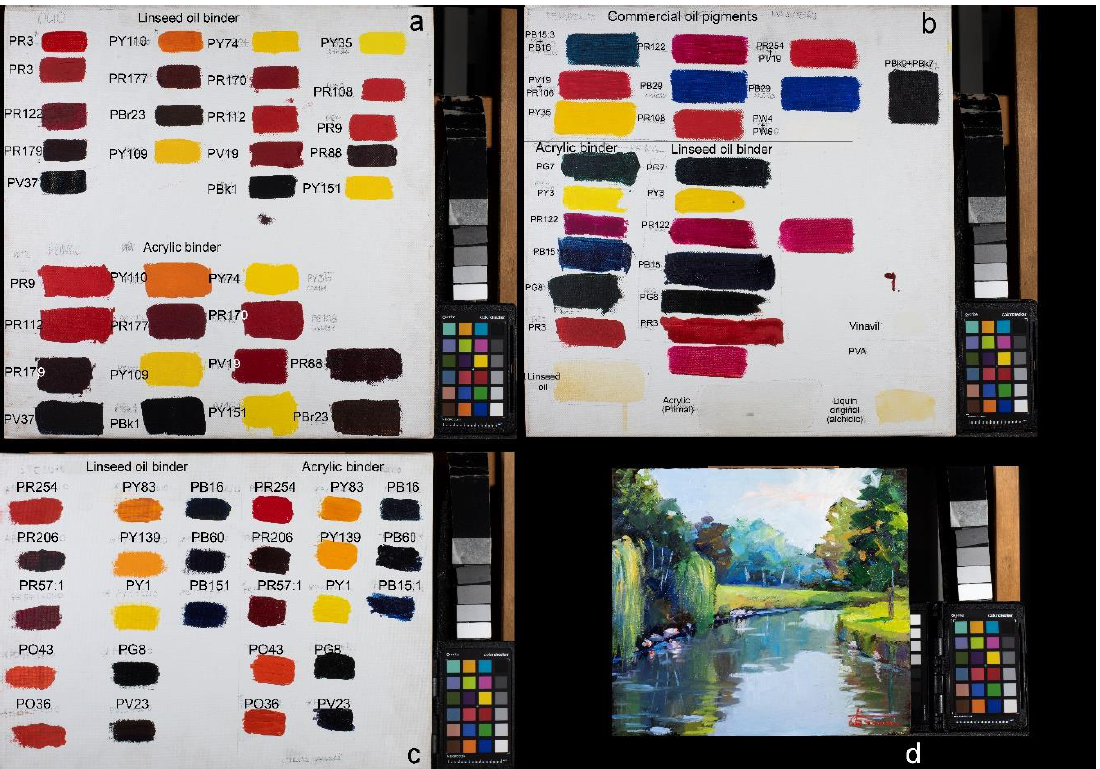
Figure 2. Overview of all the mock-ups (a, b and c) with different combination of pigment and binders and a painting used in this work (d). For each panel, reference targets were positioned bottom-right consisting of: Spectralon ® multi-step targets of 99, 50, 25, and 12% reflectance used as non-fluorescent materials to set the correct RGB and Xrite Colorcheker ® for the colour management of the Vis images.